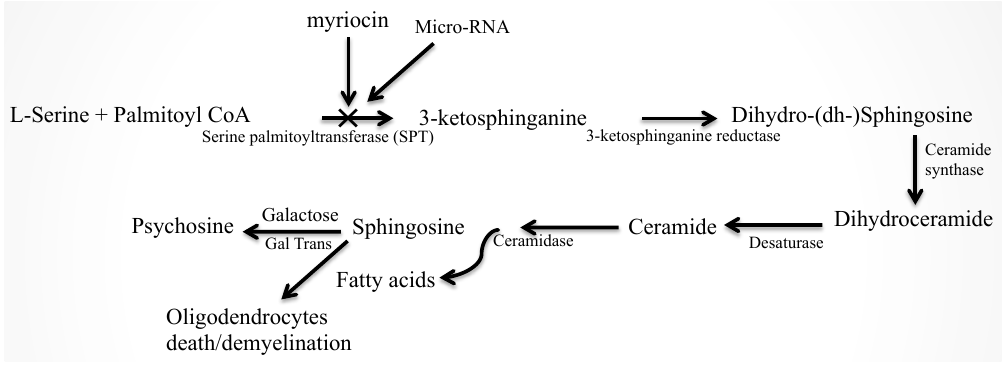
Figure 2. Ceramide and sphingosine generation via SPT activation and its inhibition by myriocin and miRNA. The biosynthesis of sphingolipids (dihydrosphingosine, ceramides, and sphingosine) in the de novo pathway begins with the condensation of palmitoyl-CoA and L-serine by serine palmitoyltransferase (SPT), producing 3-ketosphinganine or 3-ketodihydrosphingosine. The rate- limiting enzyme of the sphingolipid biosynthesis pathway is SPT, which can be pharmacologically inhibited by myriocin. Then, 3-ketosphinganine reductase (3-ketodihydrosphingosine reductase) Figure 2: Ceramide and sphingosine generation via SPT activation and its reduces 3-ketosphinganine to sphinganine (dihydrosphingosine). Ceramide synthase or fatty inhibition by myriocin and miRNA acyltransferase converts sphinganine (dihydrosphingosine) to dihydroceramide. Dihydroceramide is dehydrogenated (desaturated) at C3–C4 of the sphinganine of dihydroceramide by desaturase to generate ceramide. The action of ceramidase converts ceramide into sphingosine via releasing fatty acids. The enzyme galactosyltransferase catalyzes the reaction between sphingosine and UDP-galactose to produce psychosine